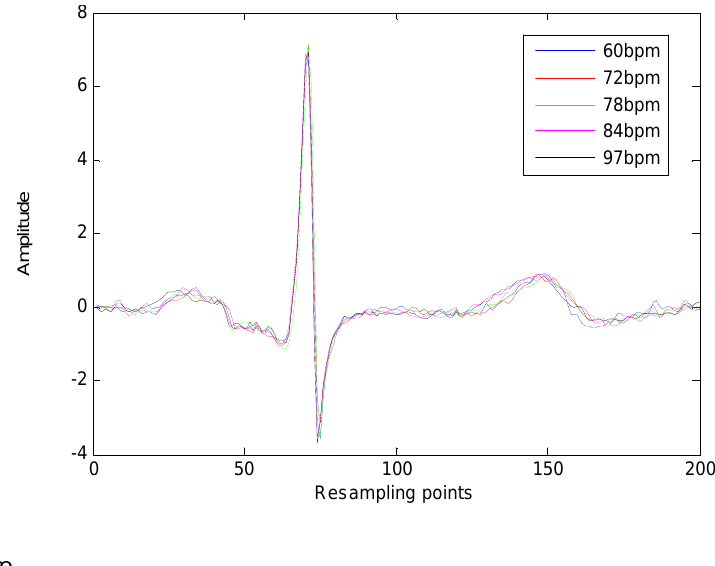
Figure 10. ECG waveform of record 302 m after